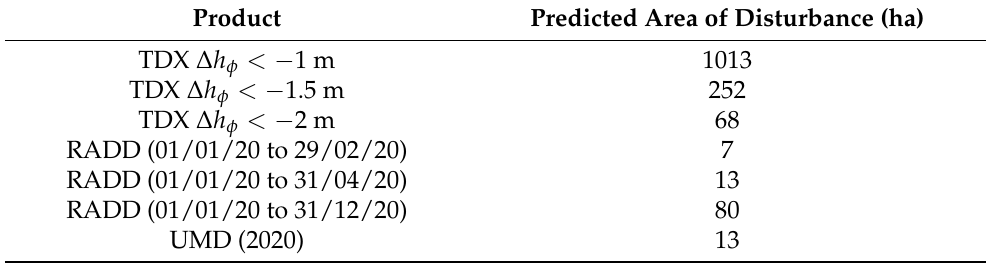
Table 4. Total estimated area of disturbance in our study area according to TDX phase height, Radar for Detecting Deforestation (RADD) alerts generating using S-1 data, and University of Maryland (UMD) forest loss for the year 2020. TDX and RADD are analysed at different cutoffs for phase height decrease and date of detection,